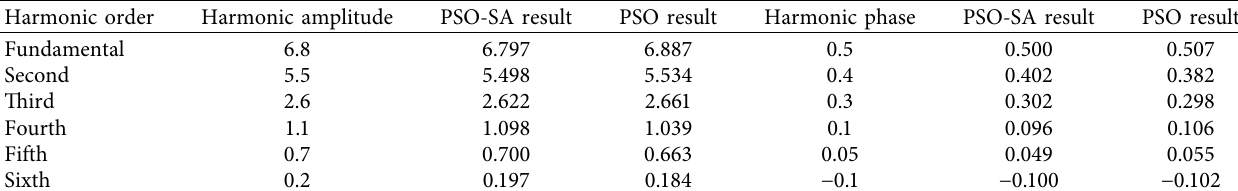
Table 1: Results of harmonic detection based on PSO-SA and PSO